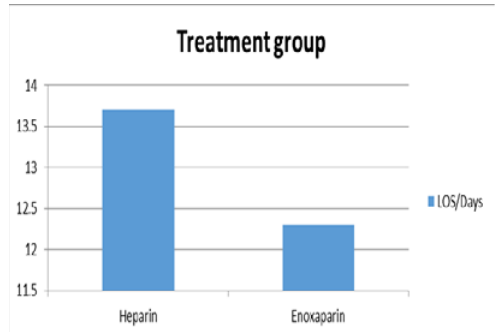
Table 6. Survival rate and test of equality